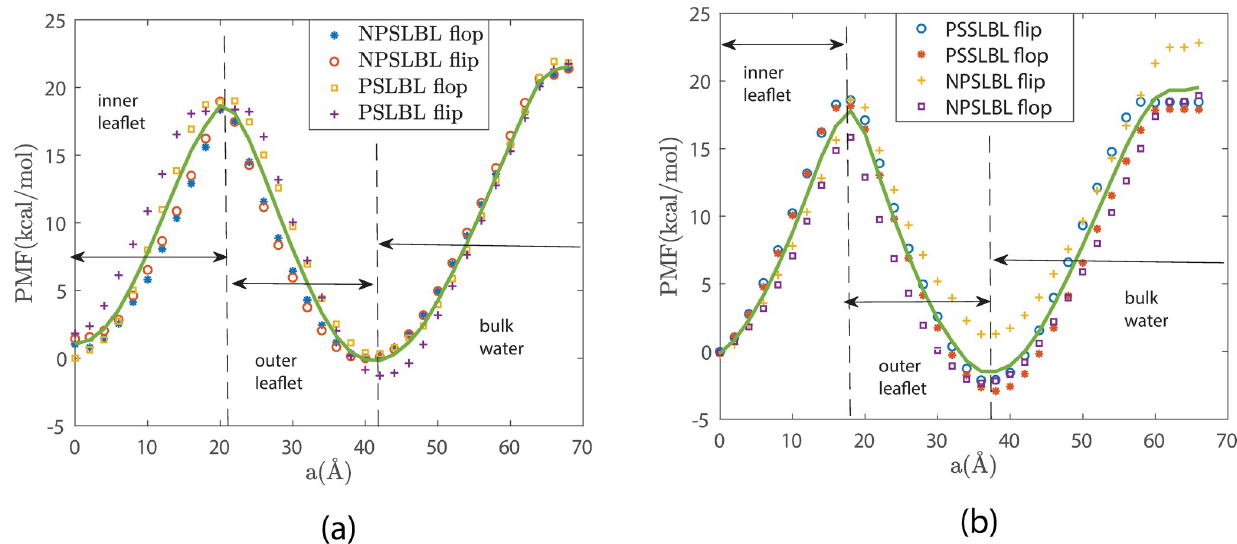
Fig 4. Variation of the PMF [with respect to the reaction coordinate ( a )] of a single lipid molecule traversing inside the LBL during the flip and the flop motions and outside the LBL during the desorption. Results are shown for systems A (NPSLBL with NP composed of Nda beads) and C (PSSLBL with the planar support composed of Nda beads) in part (a) and for systems B (NPSLBL with NP composed of P5 beads) and D (PSSLBL with the planar support composed of P5 beads) in part (b). The solid lines in parts (a) and (b) are the averages of the simulation data. Also, in both (a) and (b), we identify the locations of the lipid bilayer and the bulk water. Furthermore, a = 0 Å represents the location of the inner leaflet for both the NPSLBL and the PSSLBL.